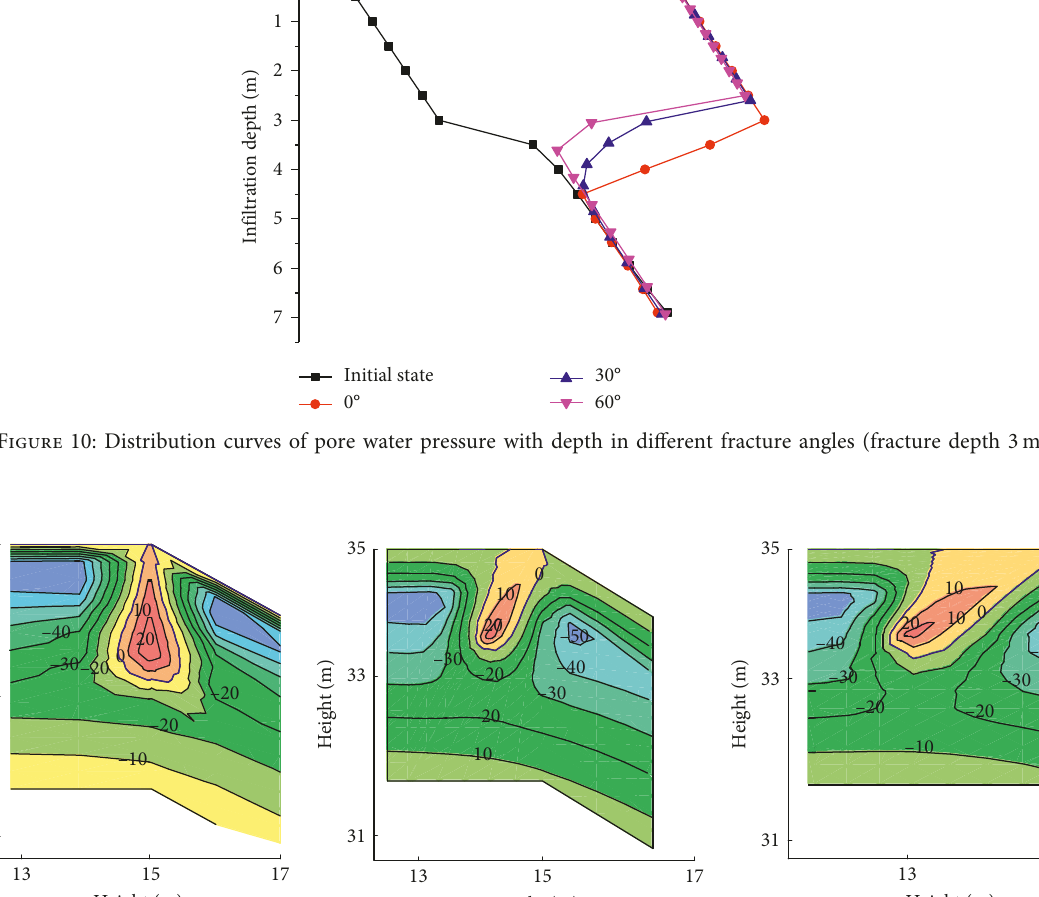
0 ° ; (b) θ 30 ° ; (c) θ 60 ° (cid:31) (cid:31) (cid:31)